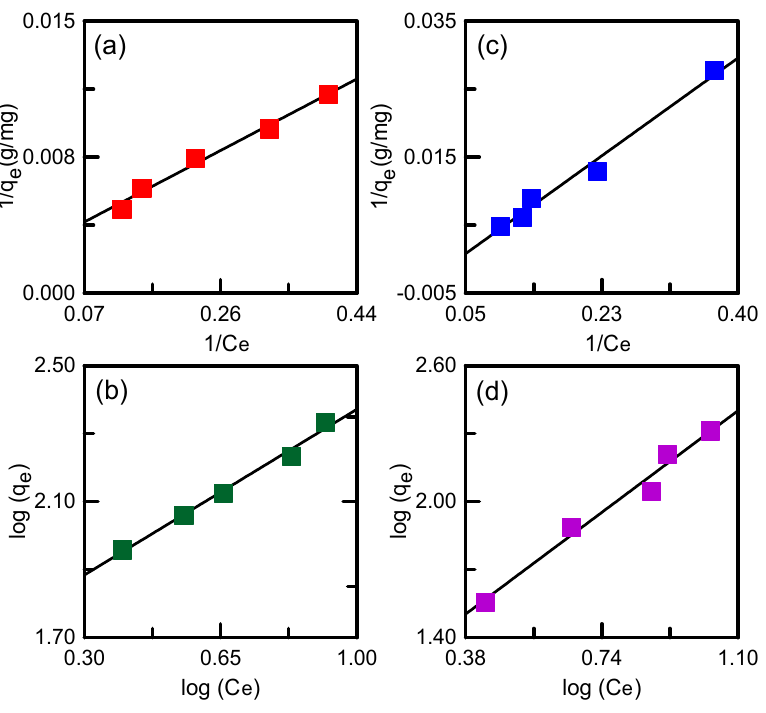
Figure 12. Plots of Langmuir model for ( a ) SBA ‐ 15/APTES and ( c ) SBA ‐ 15/PEHA; Freundlich model for ( b ) SBA ‐ 15/APTES and ( d ) SBA ‐ 15/PEHA. Table 3. Isotherm constants for TA adsorption onto amino ‐ modified silica specimens. Langmuir Freundlich Langmuir Sample